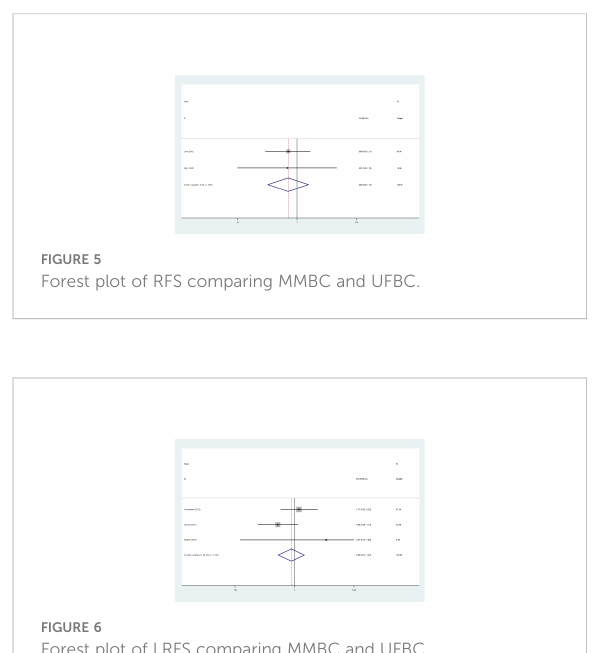
FIGURE 4 Forest plot of BCSS comparing MMBC and UFBC.